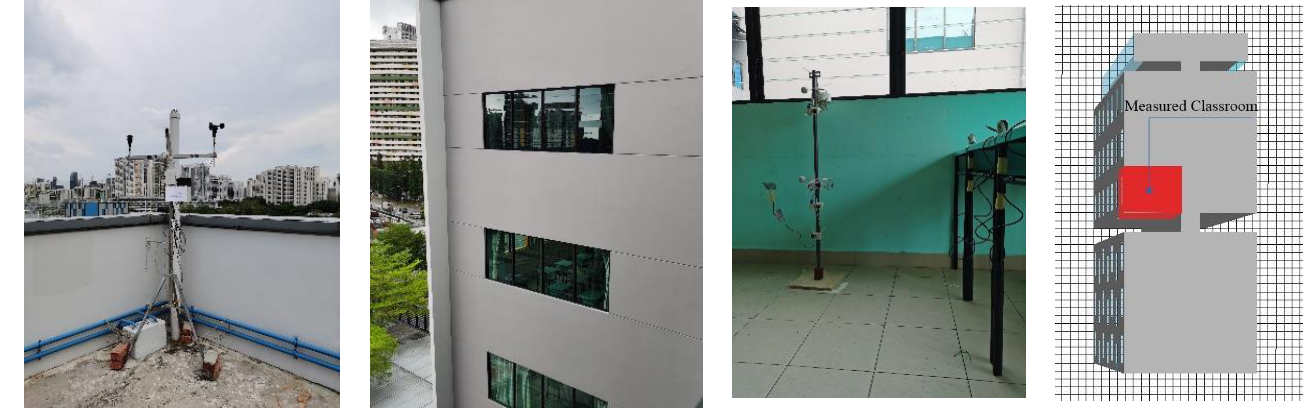
Figure 6. The settings of the field measurement and Envi-met model.